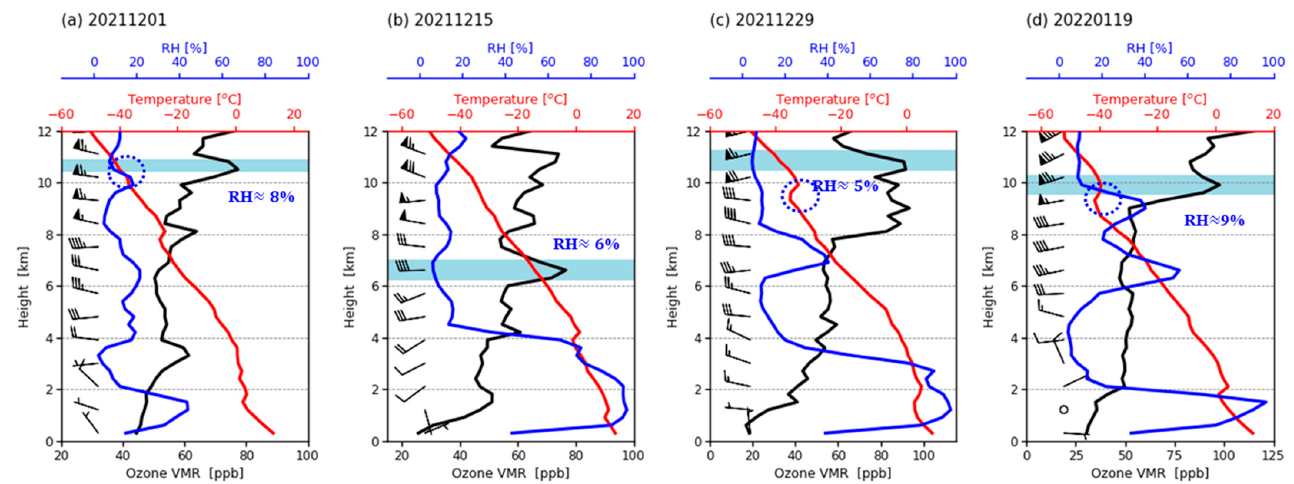
Figure 7. Profiles of tropospheric OVMR (black line), air temperature (red line), relative humidity (blue line), inversion structure (blue dash circles) and horizontal winds (vectors) measured on ( a ) 1 December 2021; ( b ) 15 December 2021; ( c ) 29 December 2021 and ( d ) 19 January 2022. The sub-peak of each profile is highlighted in blue background and the corresponding relative humidity is also shown.